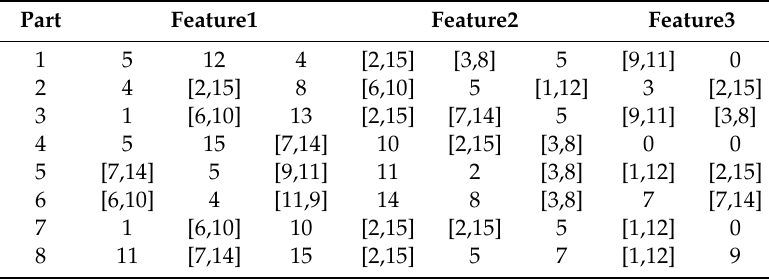
Table 1. Parts’ features selectable machine tools.